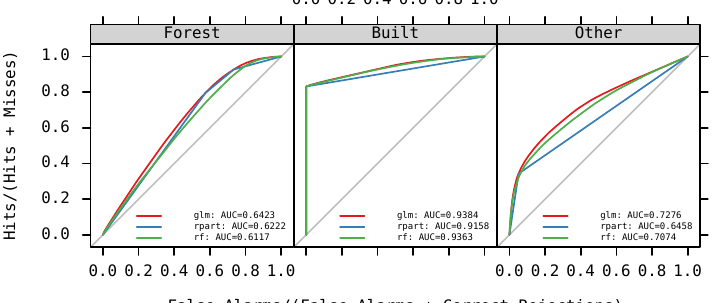
Figure 5. ROC curves showing the ability of each type of predictive model to simulate the observed pattern of land use in the Plum Island Ecosystems site in 1985 in the data partition left out of the fitting procedure.